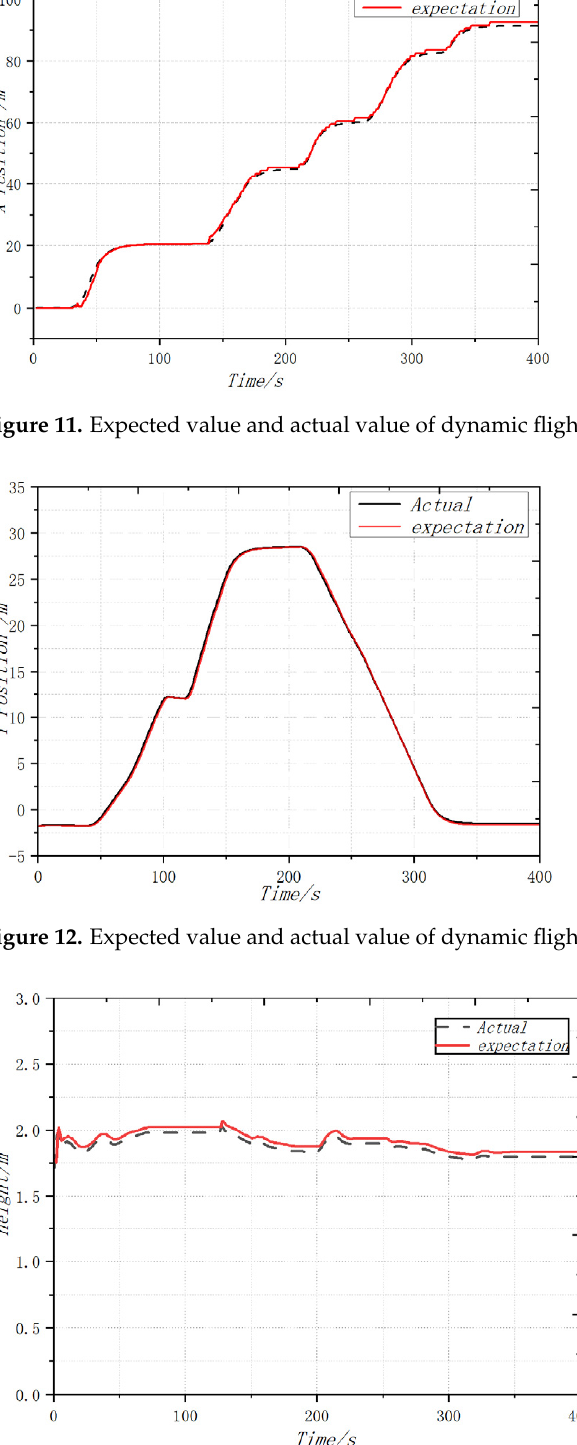
Figure 13. Expected value and actual value of dynamic flight Z direction.